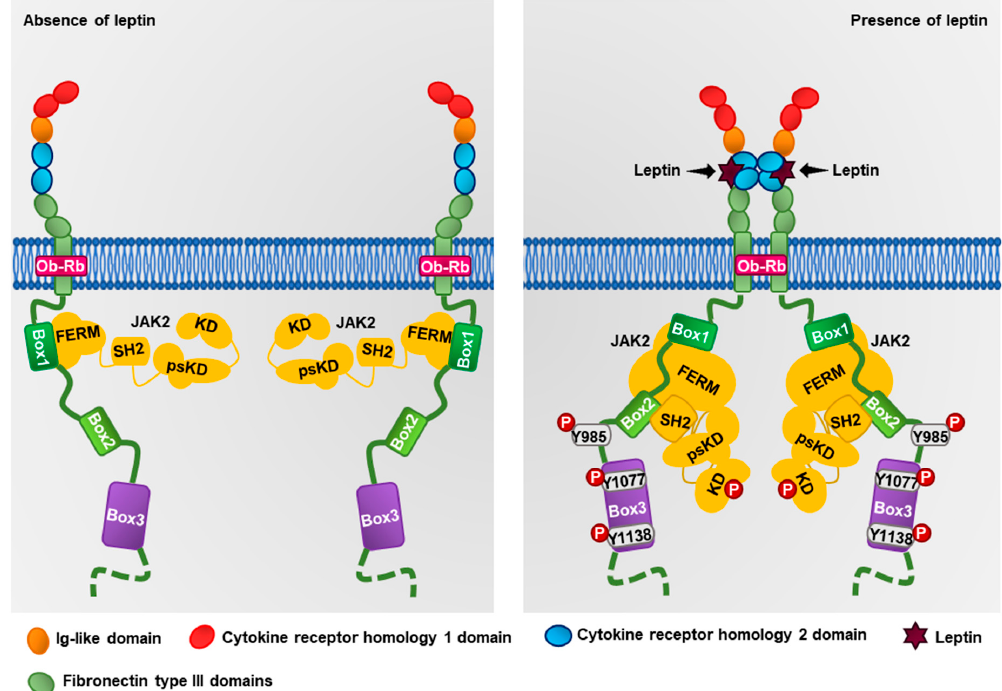
Figure 1. Structure of the ObRb receptor. The ObR is constituted by an extracellular N-terminus domain, a transmembranal domain, and a cytoplasmic C-terminus domain. In the absence of leptin, ObR is located in the plasma membrane as a monomer associated with inactive JAK. Upon leptin binding to ObRb, ObRb dimerizes, and the JAK kinase is autophosphorylated, favoring its activation. Once active, JAK2 phosphorylates tyrosine residues in ObR and activates downstream signaling pathways.